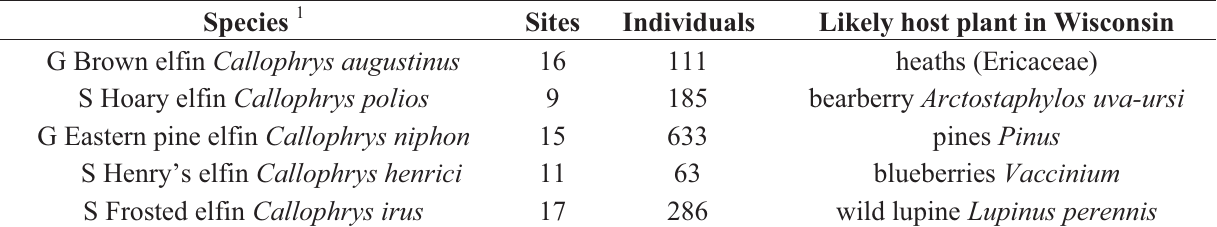
Table 1. Number of long-term sites, sum of peak annual counts of elfin individuals from those sites used in abundance analyses, and likely larval host